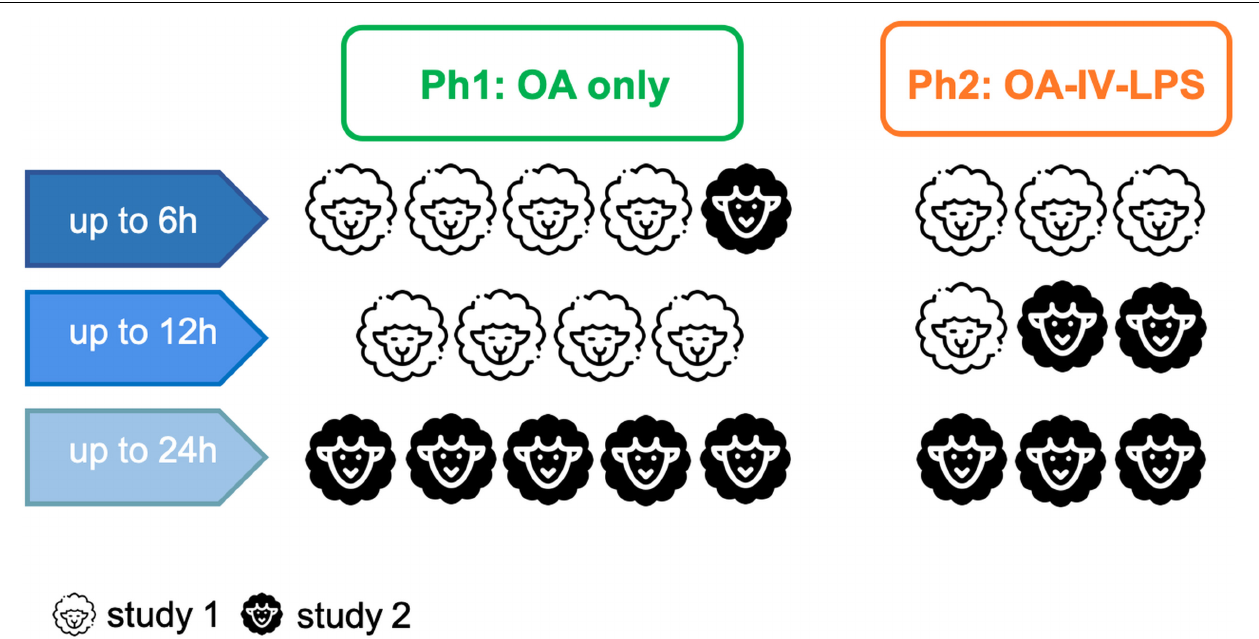
FIGURE 1 | Overview of participating animals, observation time and their assignment to the respective study. Abbreviations: OA, oleic acid; OA-IV-LPS, oleic acid and lipopolysaccharide intravenously; Ph1, hypoinflammatory phenotype; and Ph2, hyperinflammatory